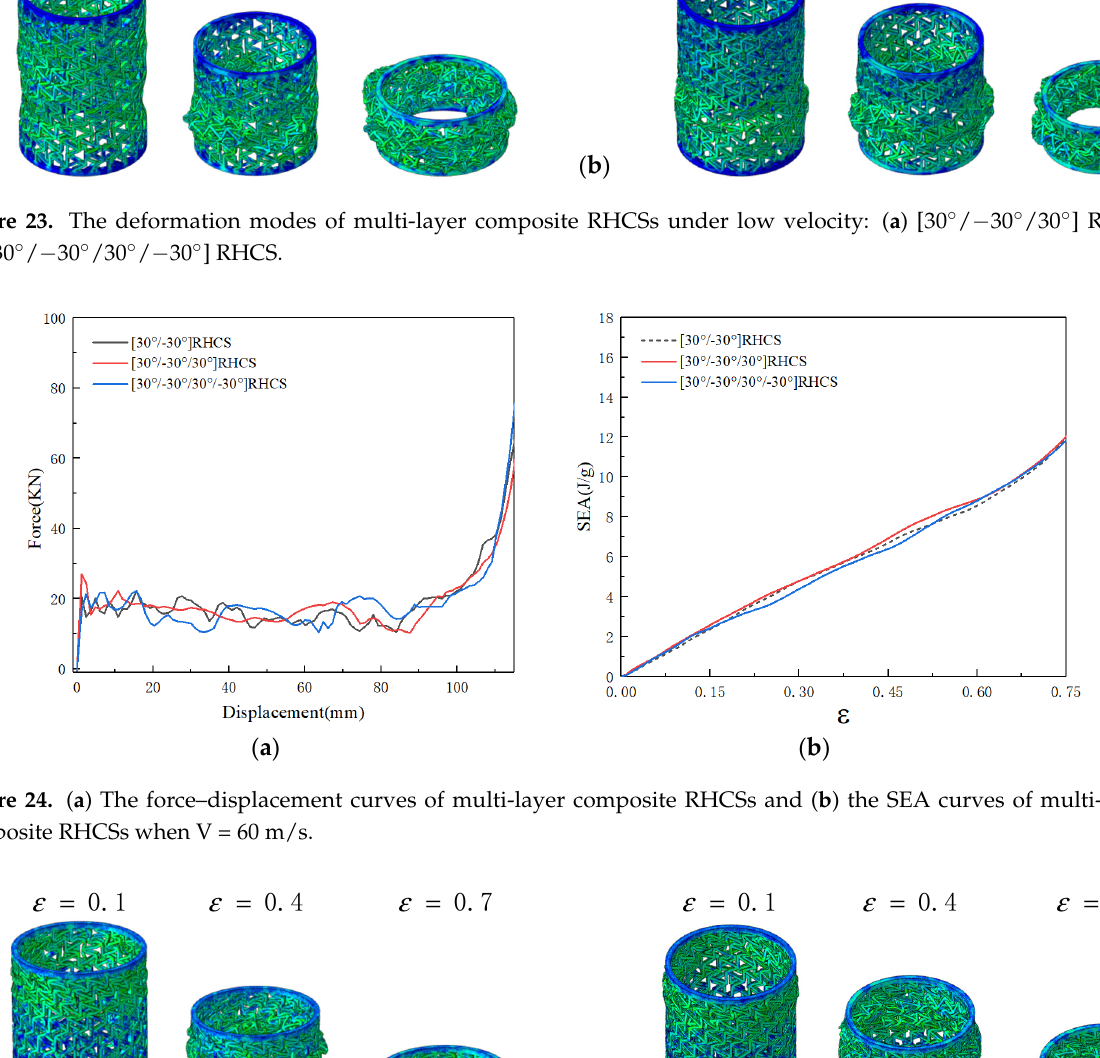
Figure 24. ( a ) The force–displacement curves of multi-layer composite RHCSs and ( b ) the SEA curves of multi-layer com- posite RHCSs when V = 60 m/s. Figure 25. The deformation modes of multi-layer composite RHCSs under high velocity: ( a ) [30°/ − 30°/30°] RHCS; ( b ) [30°/ − 30°/30°/ − 30°] RHCS.